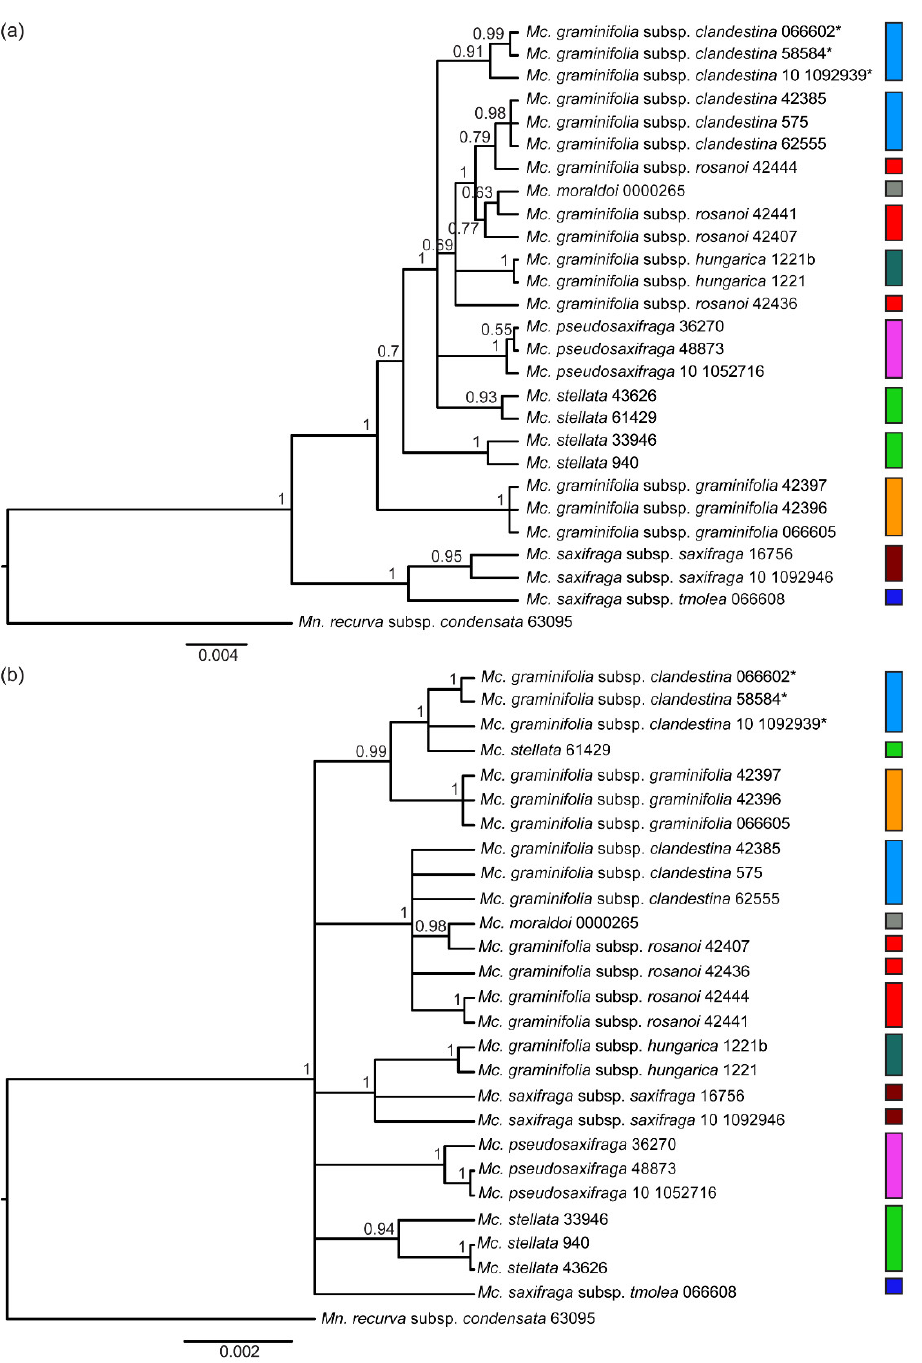
Figure 3. Consensus trees from Bayesian analyses. ( a ): nuclear dataset; ( b ) chloroplast dataset. Color codes are as in Figure 1; the asterisk (*) indicates the Balkan specimens of Mc. graminifolia subsp. clandestina .